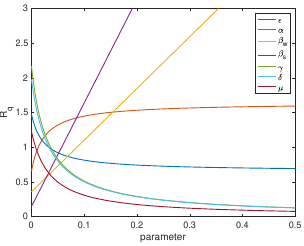
Figure 5. Variations of R q with respect to parameters of models (2.2),(3.2). Each curve in the figure simulates the variation of R q corresponding to one parameter, the rest of the parameters are fixed at values given in Table